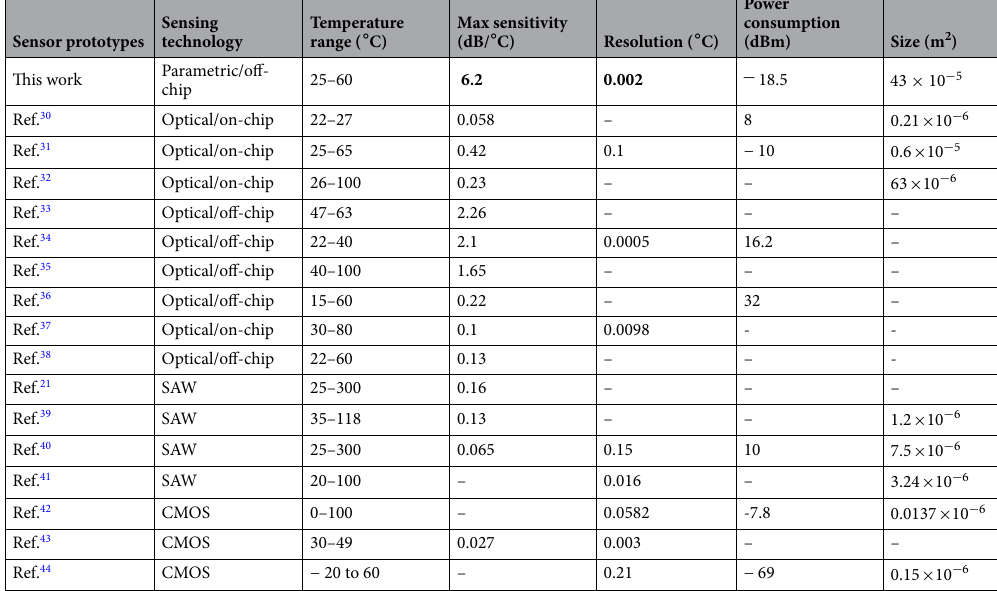
Table 1. Comparison with other temperature sensors. The maximum temperature sensitivity, the resolution, the power consumption and the size of the SubHT and of other previously reported counterparts, operating over different temperature ranges and relying on different sensing